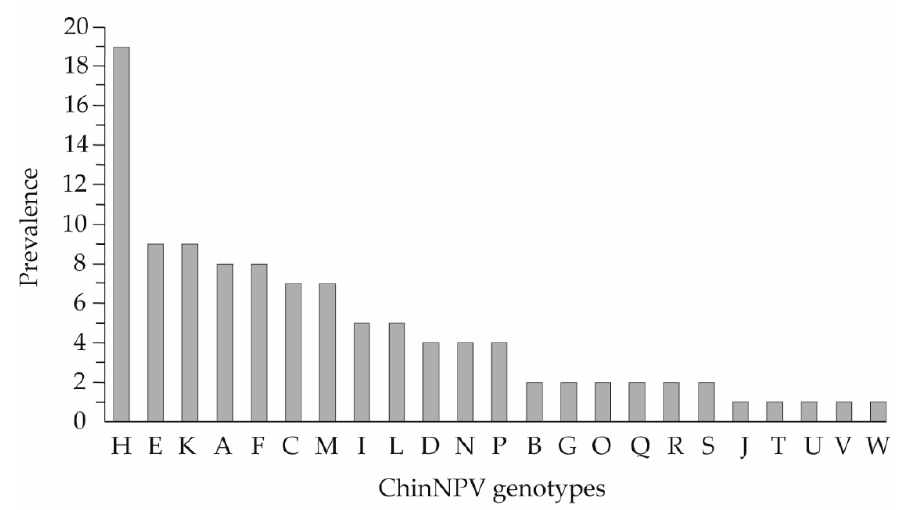
Figure 2. Prevalence of ChinNPV genotypes. Prevalence was calculated as the number of times each genotype was observed in 23 different restriction profiles from 106 clones isolated by plaque assay.